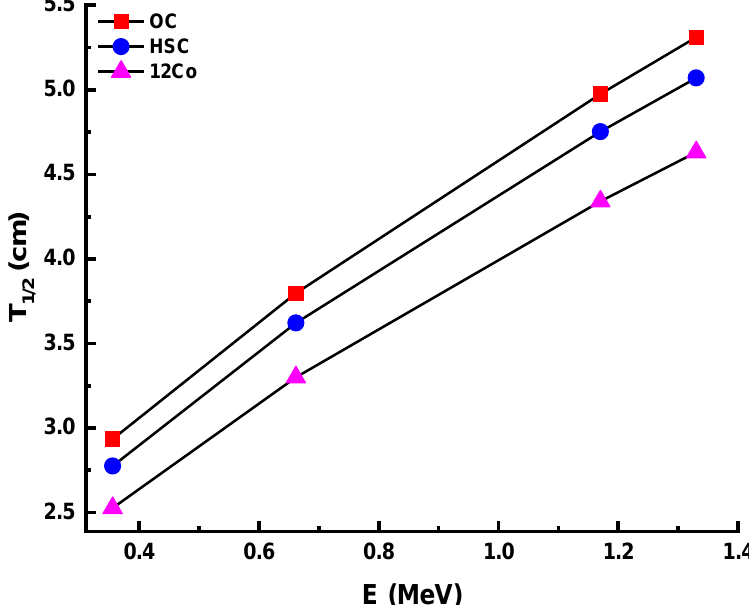
Figure 10. Experimental half-value layer (T 1/2 ) for glass samples.